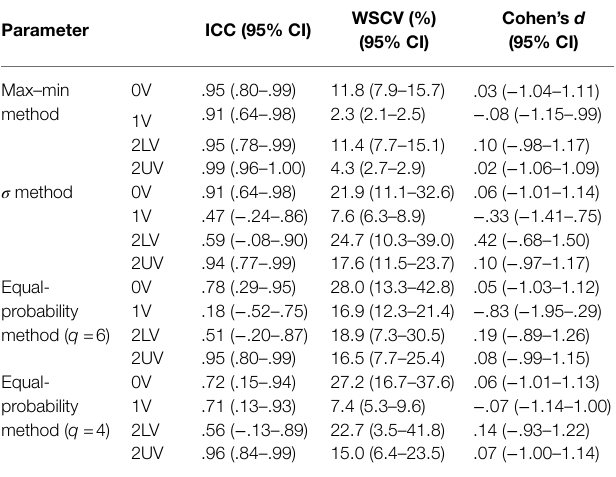
TABLE 1 | Results of reliability